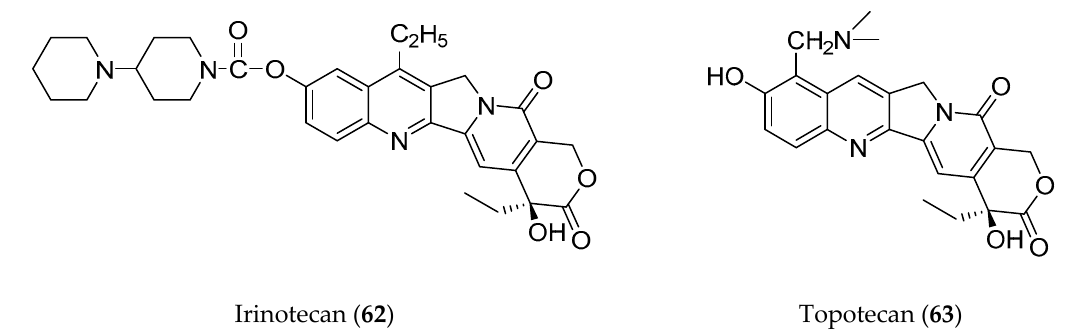
Figure 6. Campthotechin analogues.